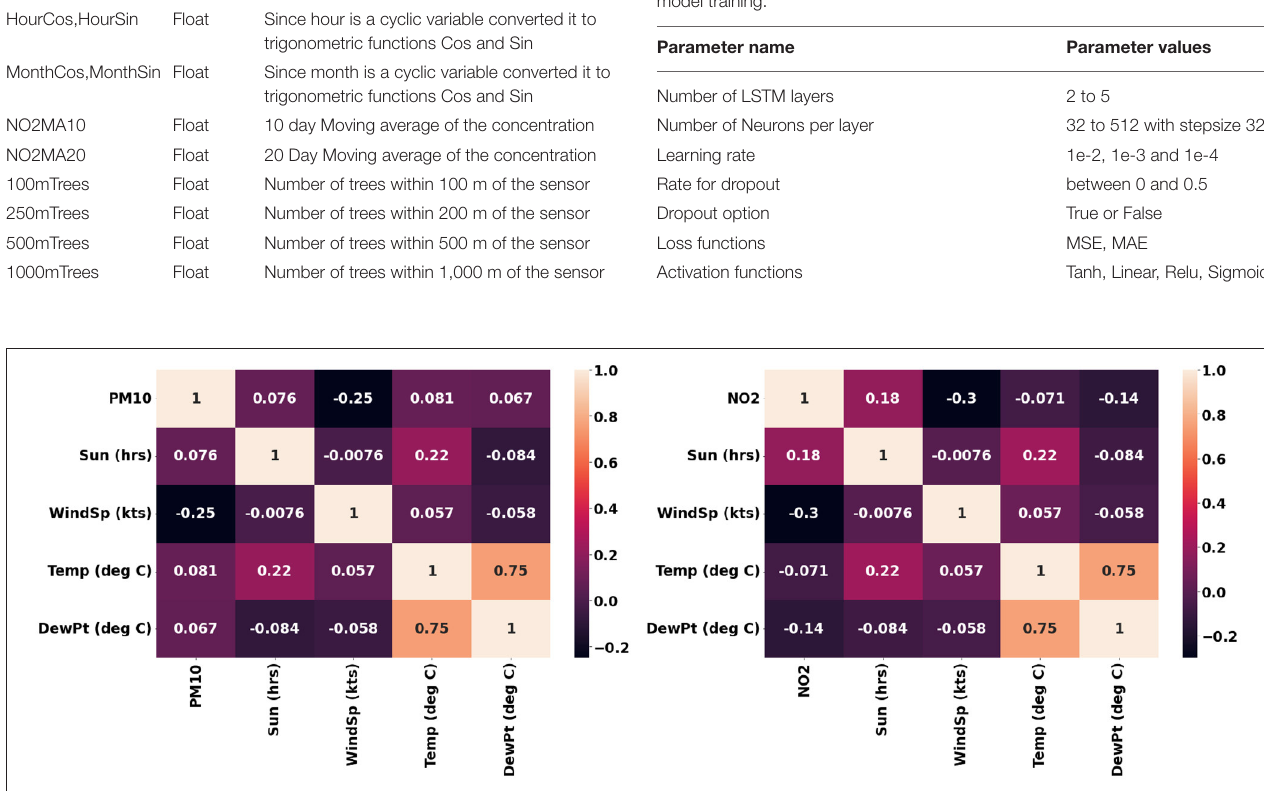
Frontiers in Big Data |